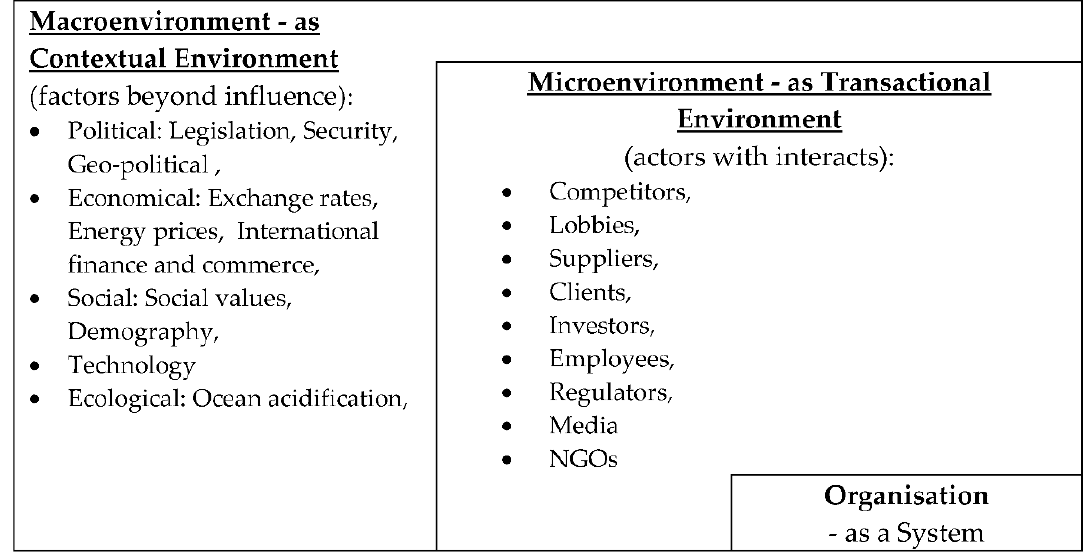
Figure 1. Analysis environments in the Oxford model (OSPM). Source: [29] (p. 12).